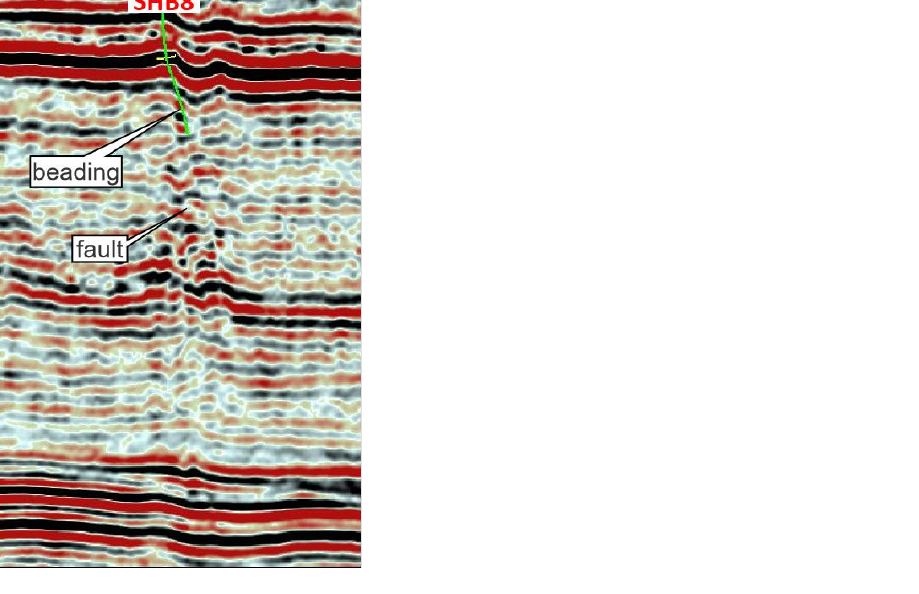
Figure 15. A seismic profile of the drilling path of the SHB8 well. The seismic data processing migration method is pre-stack reverse time migration (RTM).